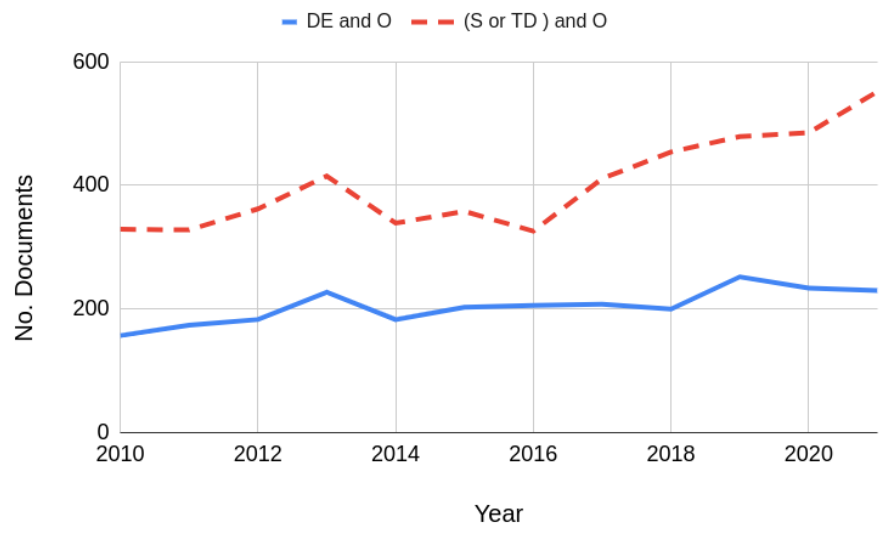
Figure 2. Number of articles indexed in Scopus for the main topics addressed in this